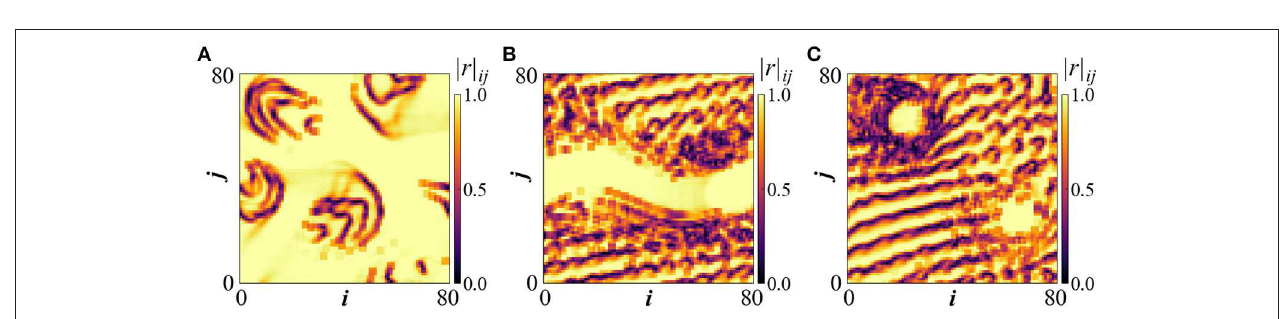
FIGURE 9 | The local order parameter r ij for (A) the spiral wave chimera as depicted in Figures 7A , (B) the stripe chimera of Figures 8A , (C) the double coherent spots of Figure 8D